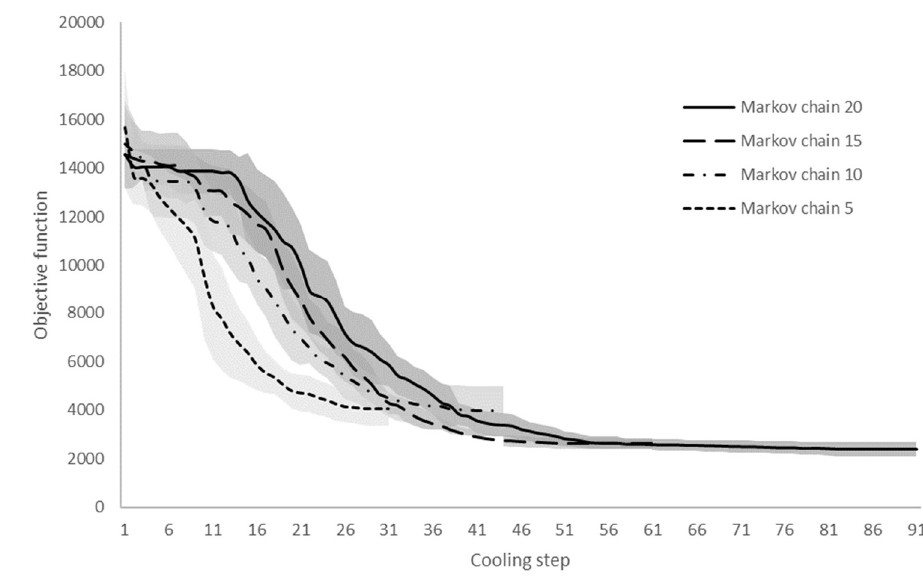
Figure 3. Objective function versus cooling step using 105 parallel